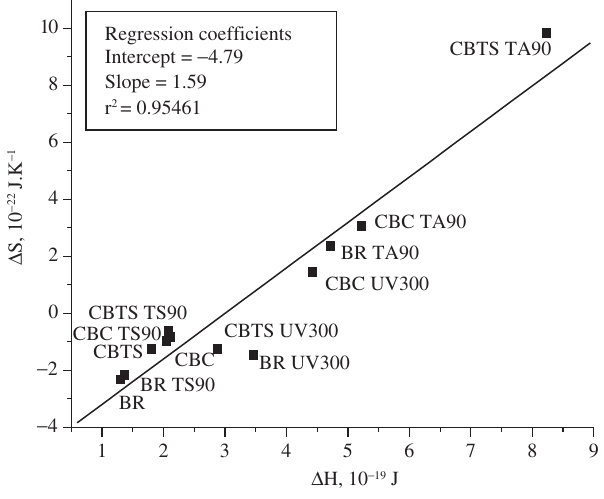
Figure 8. The ∆ S vs. ∆ H compensation plot for all the samples, before and after ageing treatments.